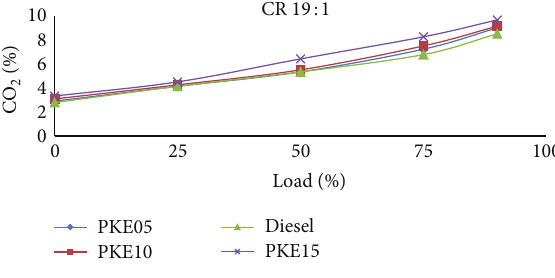
Figure 15: Load versus CO 2 emissions at 19: 1 CR.